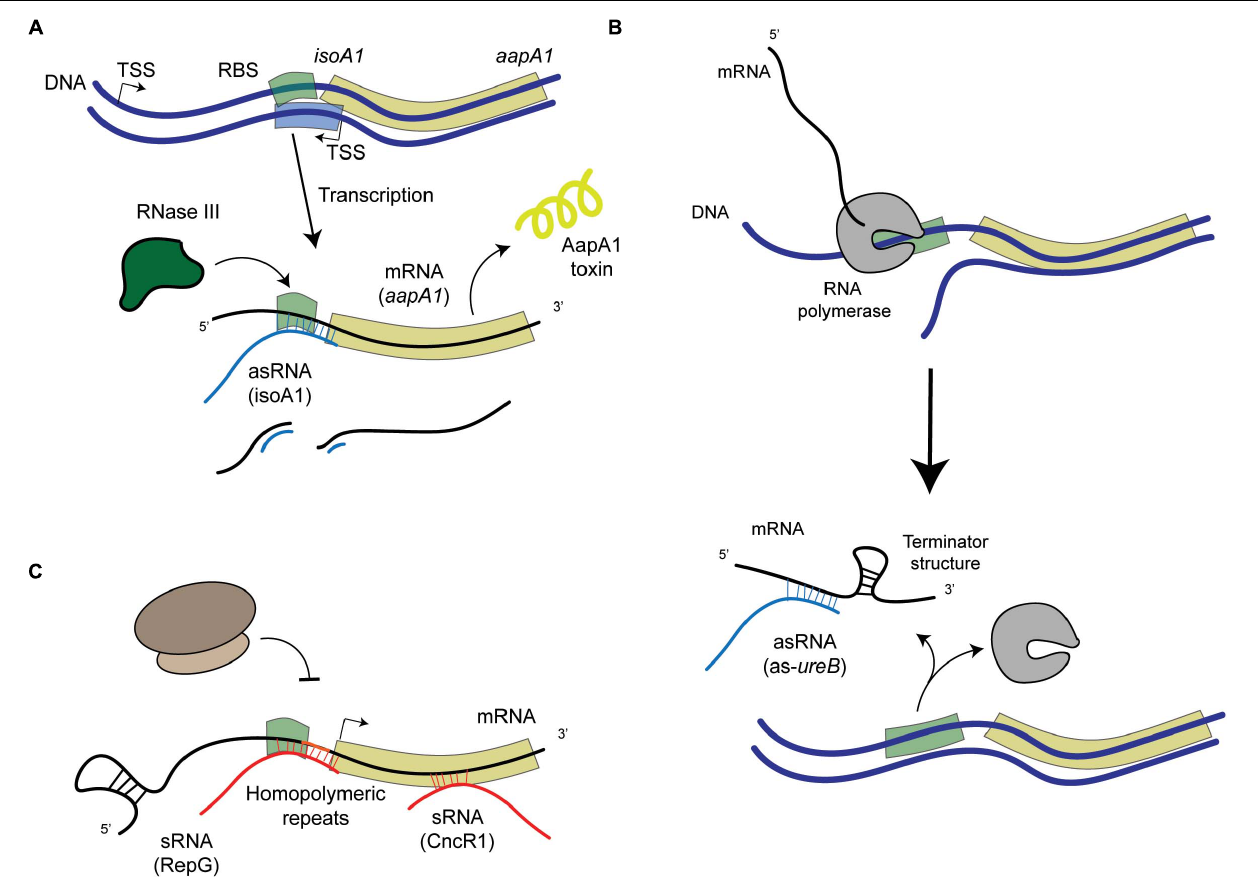
FIGURE 2 | Schematic representation of examples of post-transcriptional regulation in H. pylori . (A) asRNA-mediated regulation that leads to the degradation of the mRNA-asRNA pair by an enribodonuclease such as RNase III, like in the case of the IsoA1- aapA1 Toxin-Antitoxin system. (B) asRNA-mediated regulation that leads to the formation of a premature terminator sequence that prevents the full transcription of the target gene (as in the case of the 5 (cid:48) - ureB antisense). (C) sRNA-mediated regulation, where sRNAs (encoded elsewhere in the genome apart from their targets) can either bind homopolymeric repeats upstream from the gene (like RepG) or at different regions within the coding sequence (like